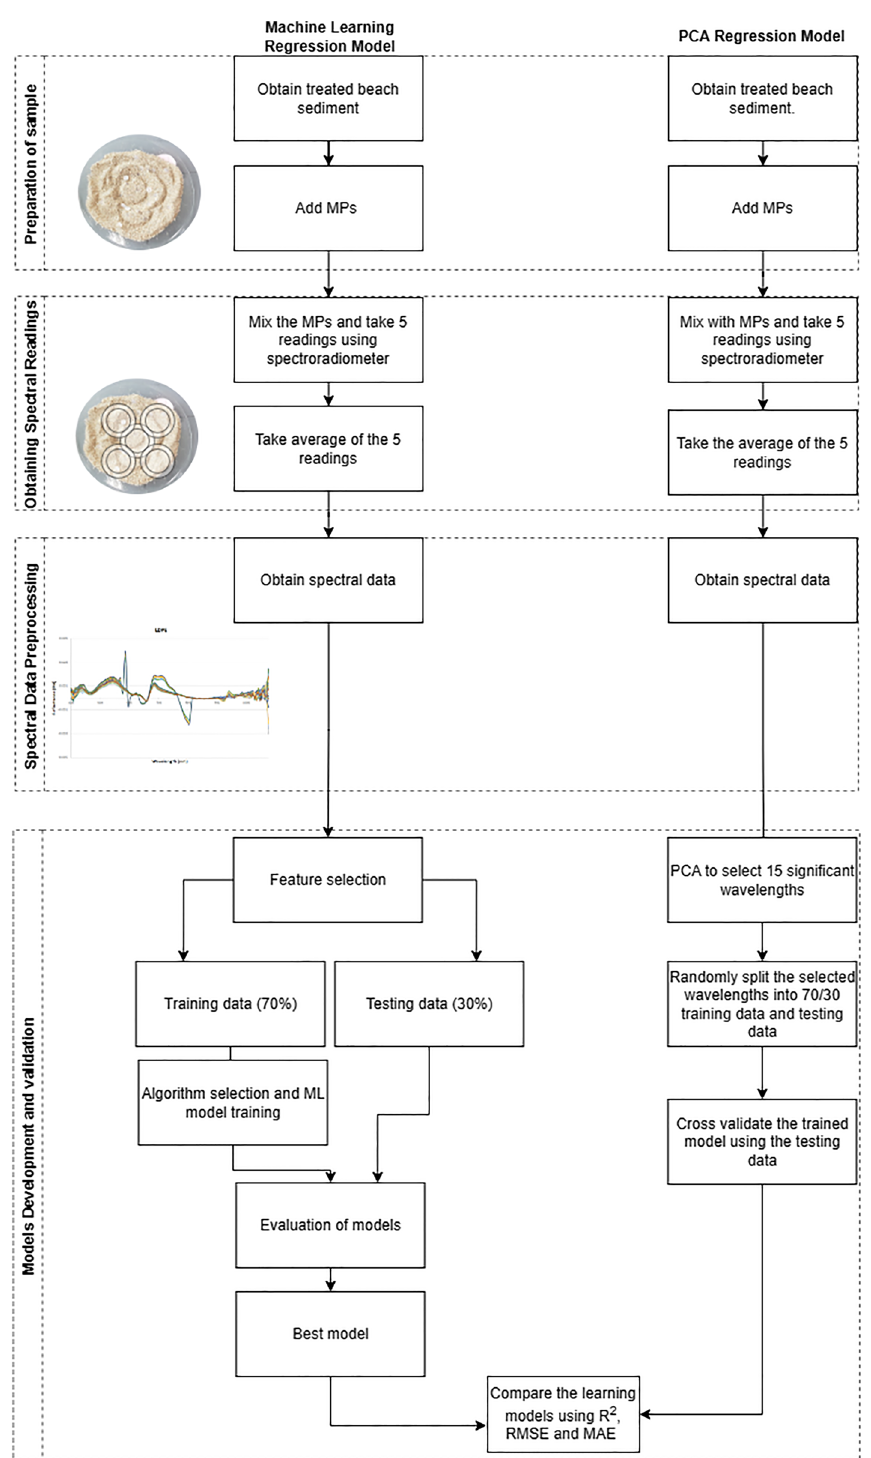
Figure 1. Summary of methodological approach to develop the predictive models. The flow diagram is divided into two sections: machine learning regression model and polynomial regression